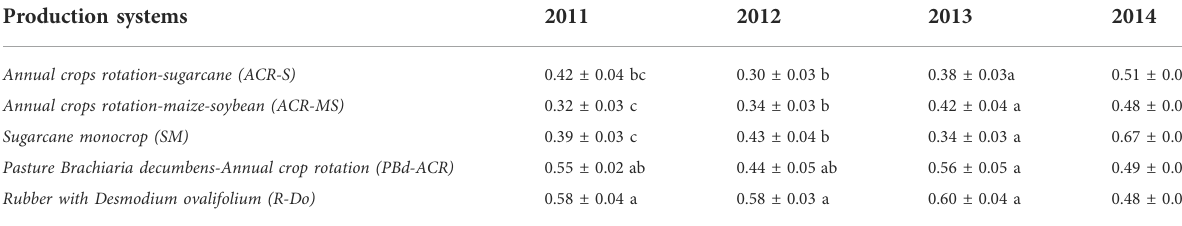
TABLE 6 Water provision indicator valued in the production systems established in an Oxisol of the Meta High Plains.